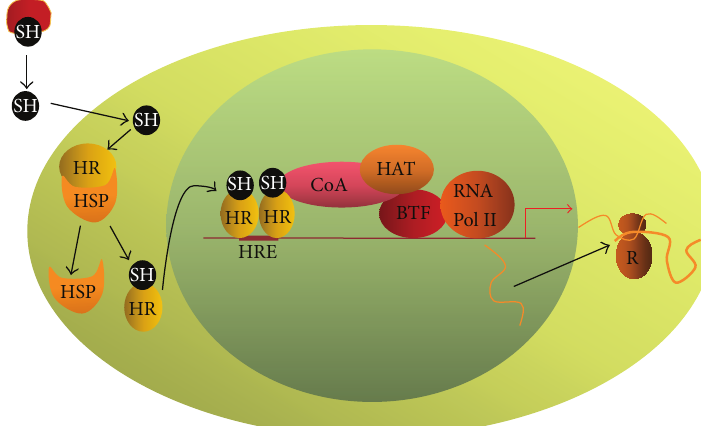
Figure 3: Diagram of type I receptor genomic mode of action. In the circulation, the majority of the hormones form complexes with transporting proteins. The hormone enters the cell by diffusion or is actively transported by specific cell membrane proteins. In the cytoplasm, hormone-free receptors form an inactive complex with heat shock chaperone proteins. Upon hormone binding, the receptor changes its conformation, dissociates from the complex, and translocates into the nucleus. Hormone-activated receptors bind to HREs as homodimers. Recruitment of a coactivator complex possessing a histone acetyltransferase activity results in local chromatin decondensation and increases the accessibility of the promoter for transcription factor. As a result, transcription increases. SH: steroid hormone, HR: nuclear hormone receptor, HSP: heat shock protein, HRE: hormone response element, CoA: coactivator complex, HAT: histone acetyltransferase, BTF: basal transcription factors, RNA Pol II: type II RNA polymerase, and R: